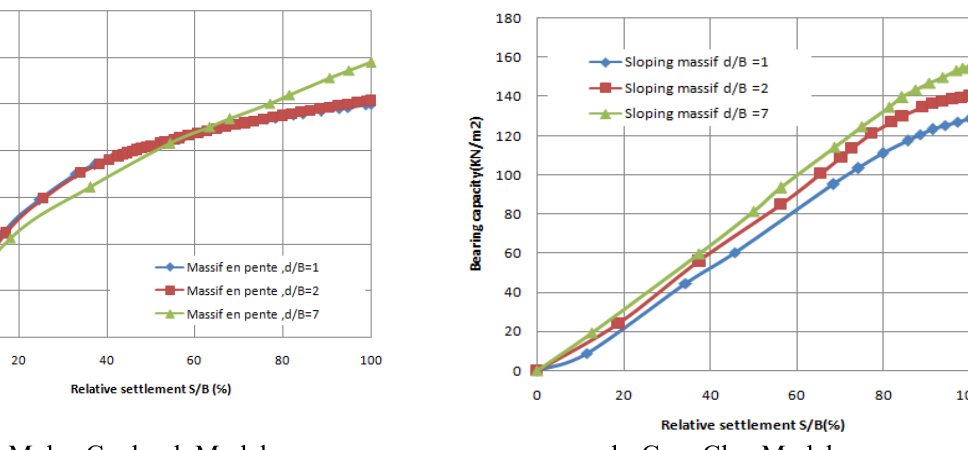
Fig.9. Evolution of bearing capacity.